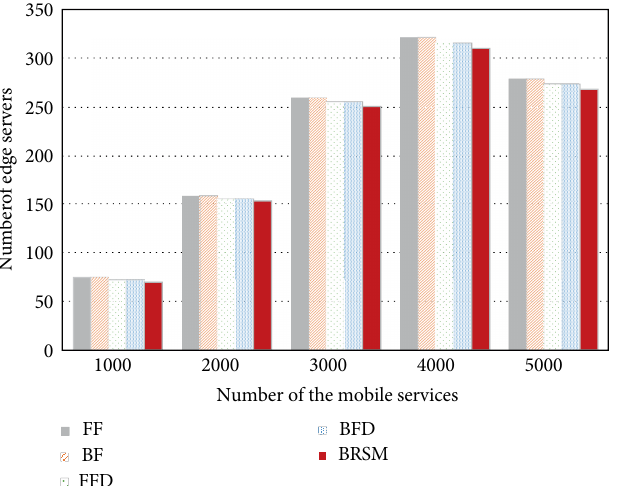
Figure 6: Comparison of the number of employed edge servers by FF, BF, FFD, BFD and